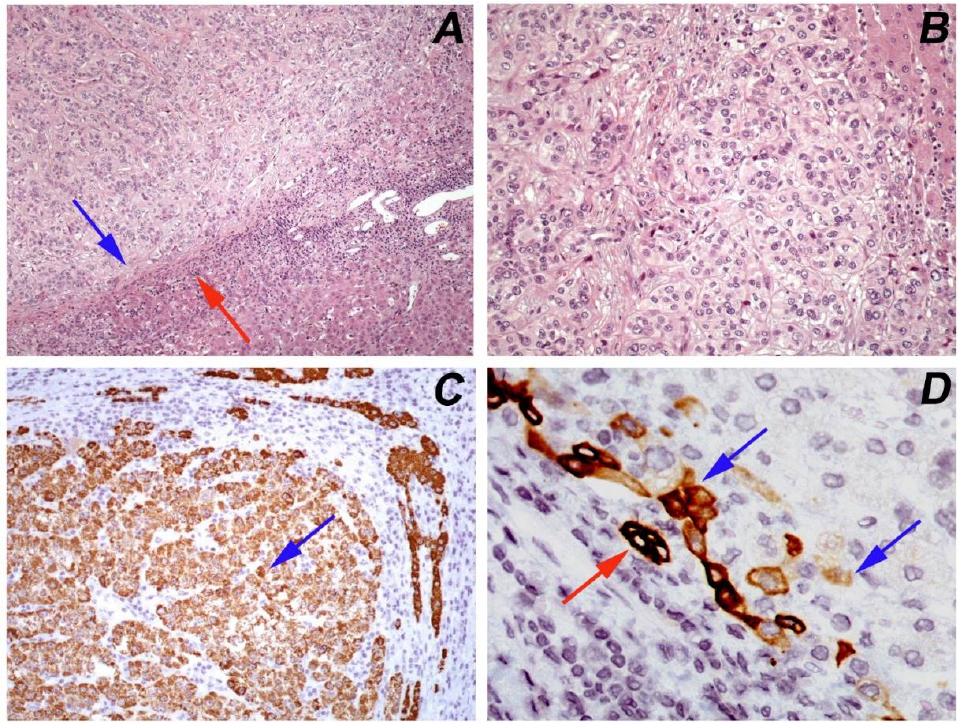
Figure 1. Hepatocellular carcinoma, moderately differentiated (Grade 2, WHO 2019): ( A ) a circumscribed tumor with a pseudocapsule (blue arrow) that separates it from the adjacent normal parenchyma (red arrow) (hematoxylin/eosin, ×100); ( B ) the tumor has a trabecular growth pattern and the neoplastic cells have abundant pale or eosinophilic nuclei with moderate nuclear atypia and prominent nucleoli (hematoxylin/eosin, ×200); ( C ) immunohistochemical positive expression of HepPar1 (blue arrow) confirms the hepatocytic differentiation of tumor cells (×200); ( D ) immunostaining of keratin 19 in few (<5%) tumor cells (blue arrow). The normal adjacent bile ducts serve as an internal positive control (red arrow) (×600).